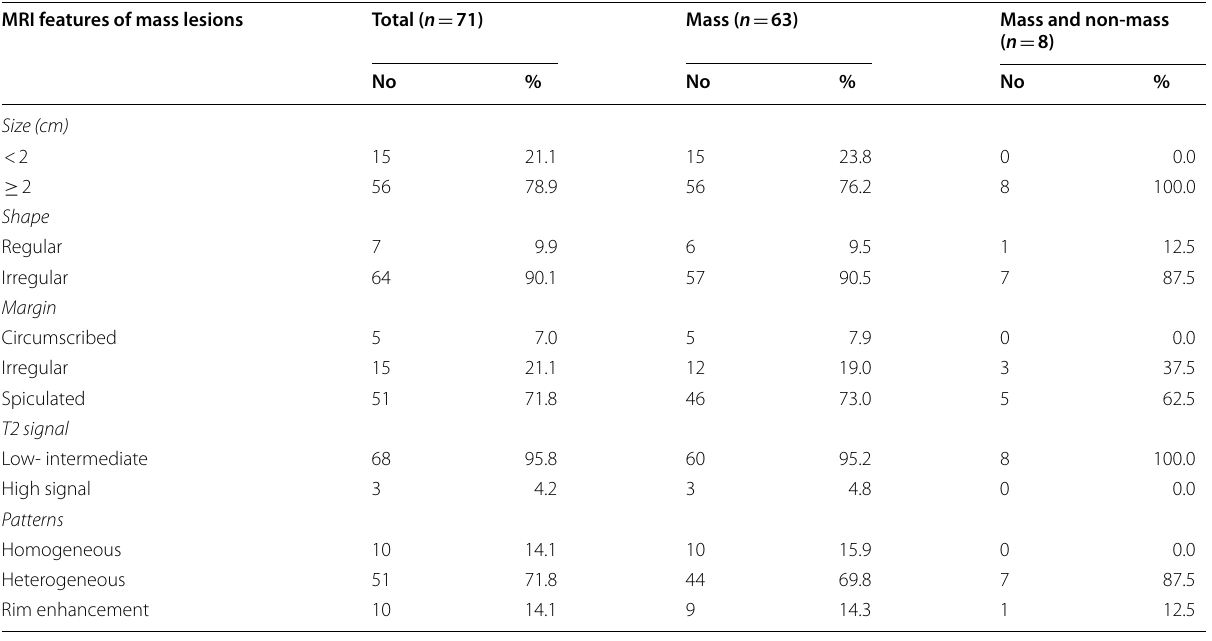
Table 1 Distribution of the studied cases according to MRI features of the mass lesions